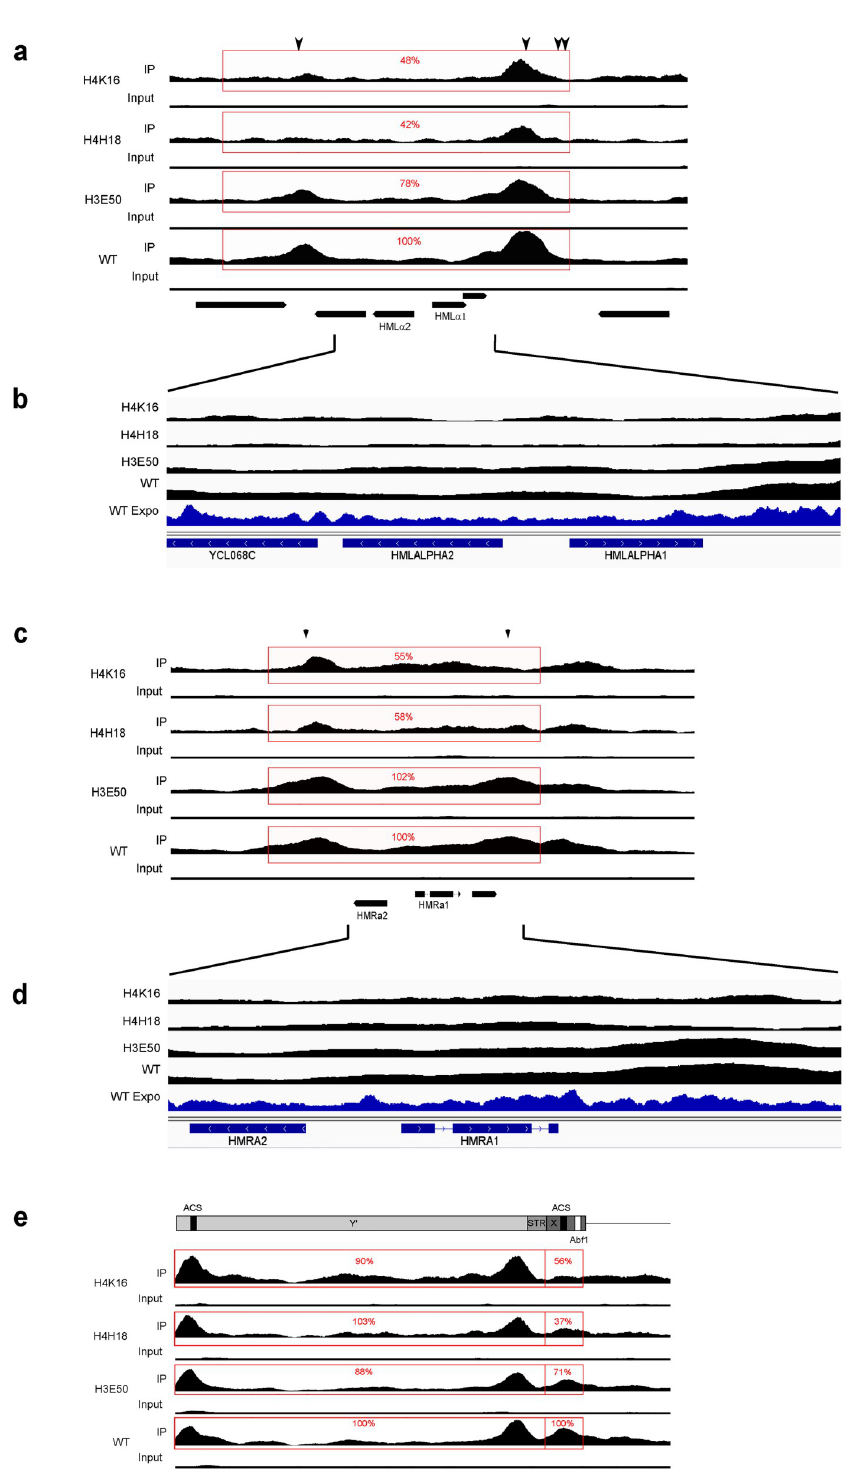
Fig 3. Redistribution of Sir3 in mutant strains. The genomic distribution of Sir3 was determined for the H4K16Q, H4H18A, H3E50A and WT strains. The immuno-precipitated and input signal, normalised to a ratio of 1, is shown for each strain at the HML α ( a ). ( b ) HML α zoomed-in IGV tracks of ( a ) compared with publicly available exponential phase Sir3 ChIP-seq WT (WT Expo) in blue track from [36]. ( c ) Sir 3 distribution at HMRa, ( d ) HMRa zoomed-in IGV tracks of ( c ) compared with publicly available exponential phase Sir3 ChIP-seq WT and left telomere of